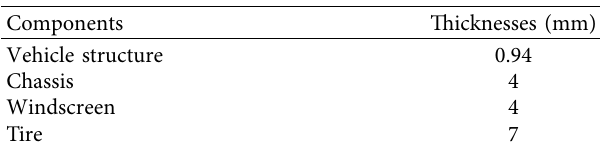
Table 2: Ticknesses. Table 3: Contact between diferent parts of BPV.